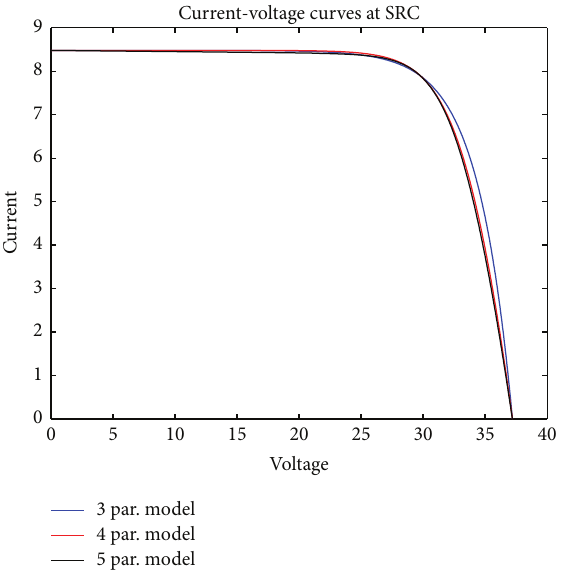
Figure 6: Current-Voltage curves at SRC of BP 3 235T, traced by using 3/4/5 parameter models.